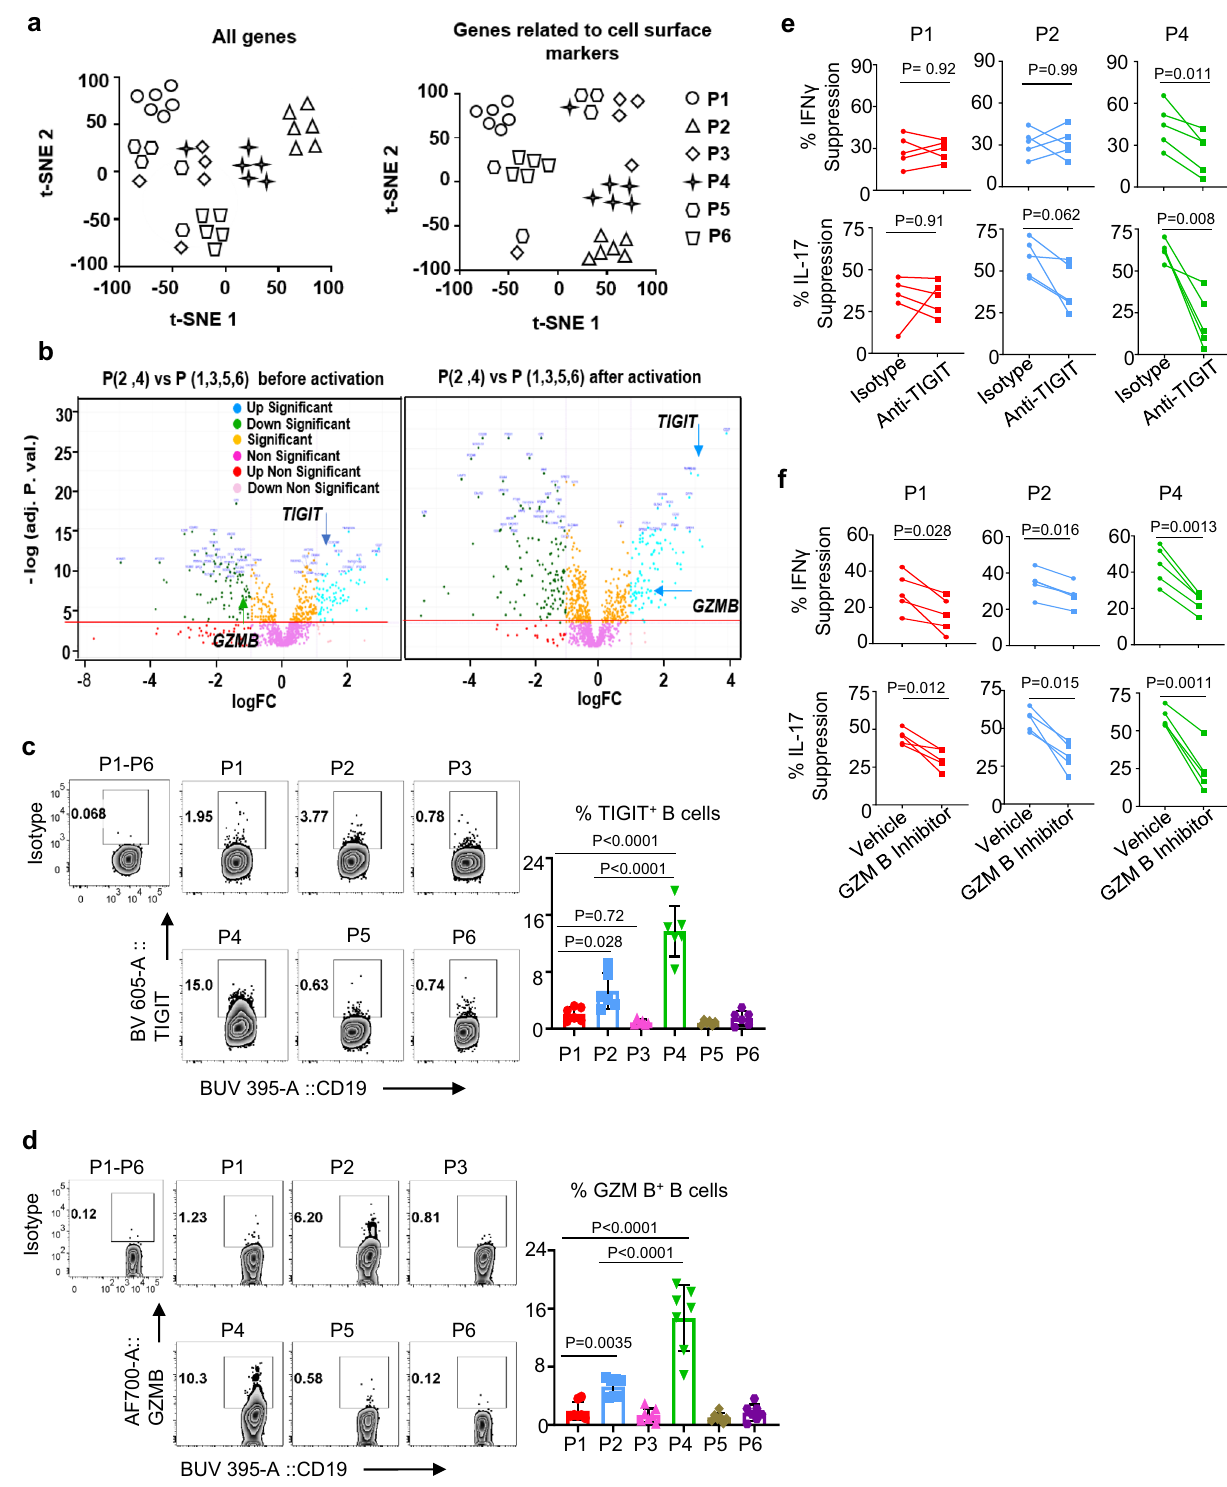
(left, Fig. 8b) and P4 memory B cells (right, Fig. 8b). DSA − patients and healthy subjects had similar numbers of those P2 and P4 B cell subsets tested. However, this was not the case of P1 TBs (Supplementary Fig. 15a). Figure 8c further shows that the frequency of CD25 + CD127 lo natural naive Tregs 27,28 correlated with the frequency of B10-like (left, Fig. 8c), P2 MZ-like (middle, Fig. 8c), and P4 memory B cells (right, Fig. 8c) expressing TIGIT, but not P1 TBs (Supplementary Fig. 15b). In addition,